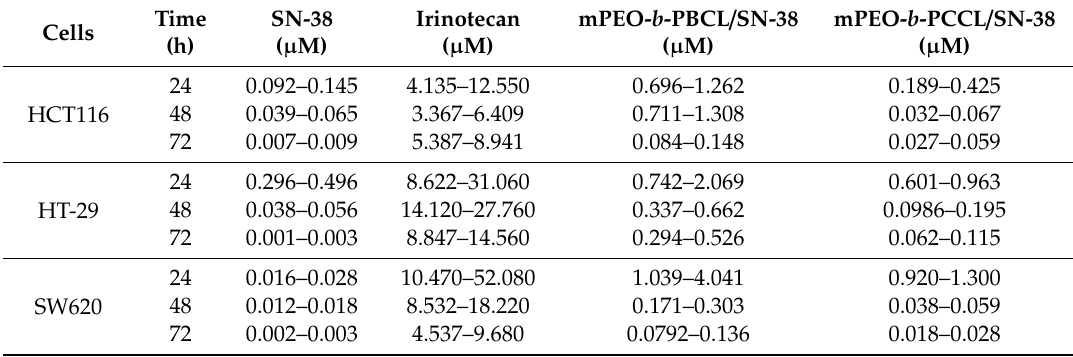
Table 3. IC 50 range of free SN-38, irinotecan, mPEO- b -PBCL / SN-38, and mPEO- b -PCCL / SN-38 against HCT116, HT-29, and SW620 cell lines after 24, 48, and 72 h of incubation ( n = 4). IC 50 values were determined after plotting the cell viability percentages vs. drug concentrations using GraphPad